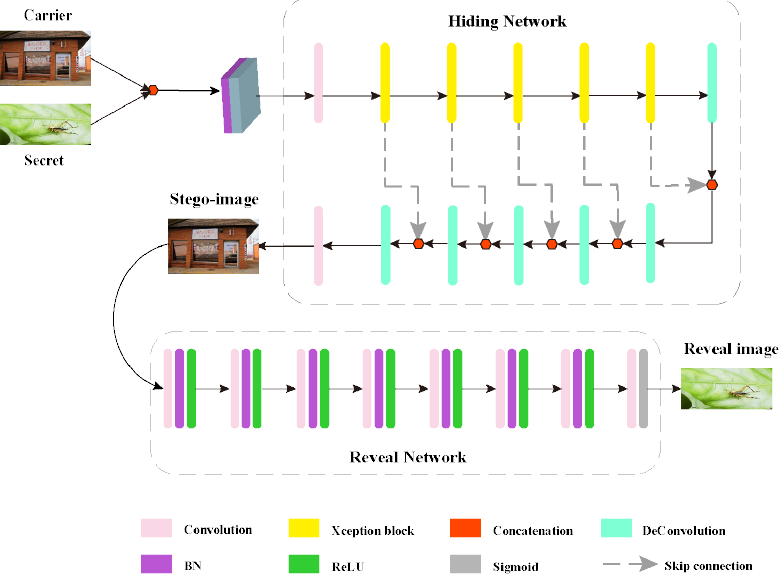
Figure 4. The proposed hidden